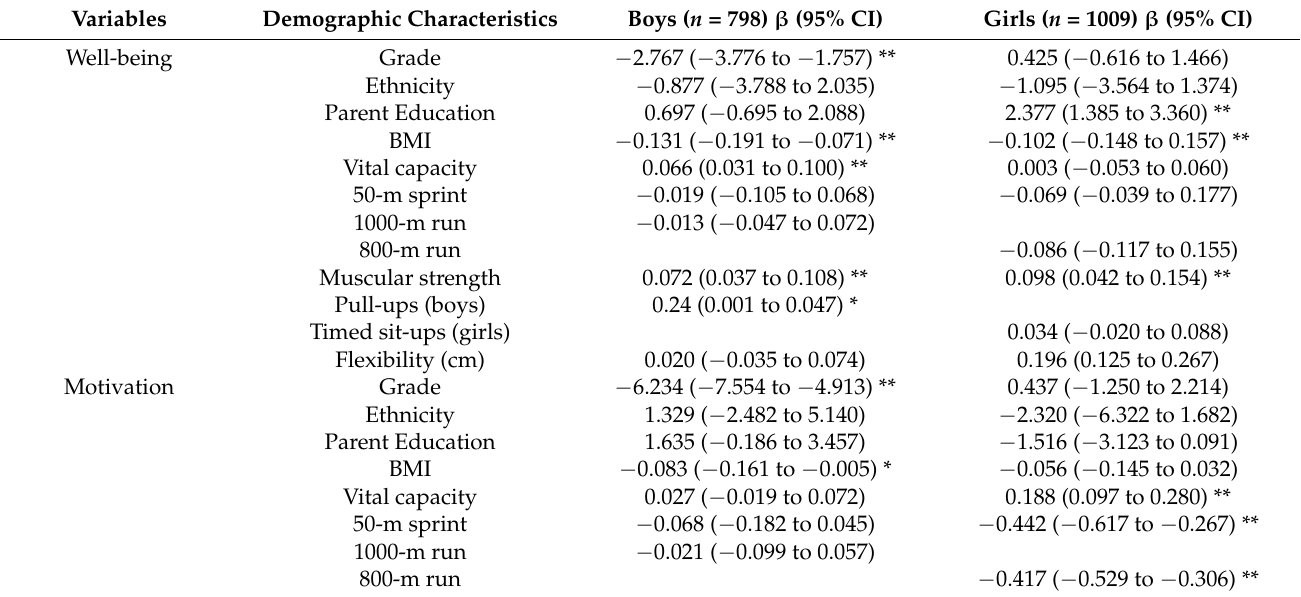
Table 2. Multivariable Generalized Linear Models Evaluating the Associations Between the Physical Fitness and Perceived Well-being, Motivation and